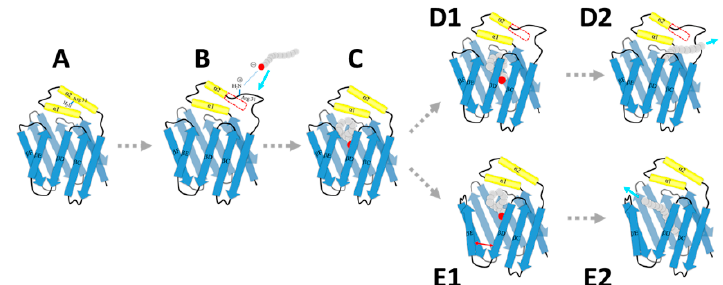
Figure 7. A schematic model of fatty acid associating and disassociating with heart FABP. The dashed arrows indicate hypothetical transitions between the intermediates. The regions in the red frames are unfolded in the corresponding intermediates. The cyan arrows are corresponding to the moving directions of the ligands. The red arrow represents the movement of two β -strands.